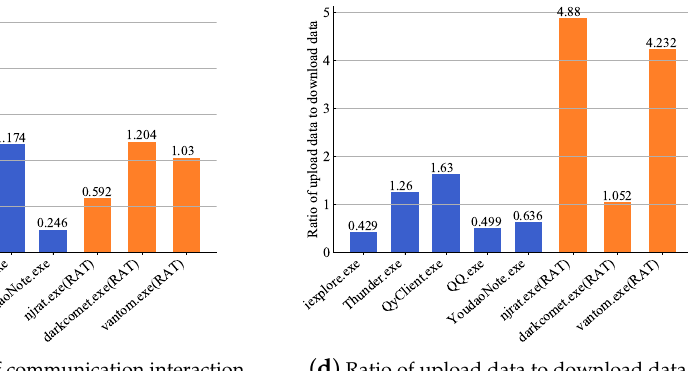
( d ) Ratio of upload data to download data Figure 3. Some characteristics of several benign programs and RATs on network